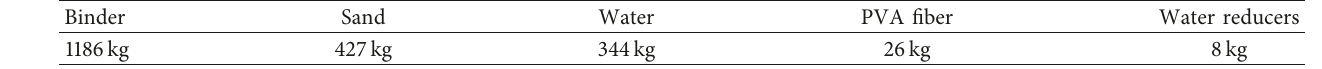
Table 1: Mix proportion of HDC (kg/m 3 ).